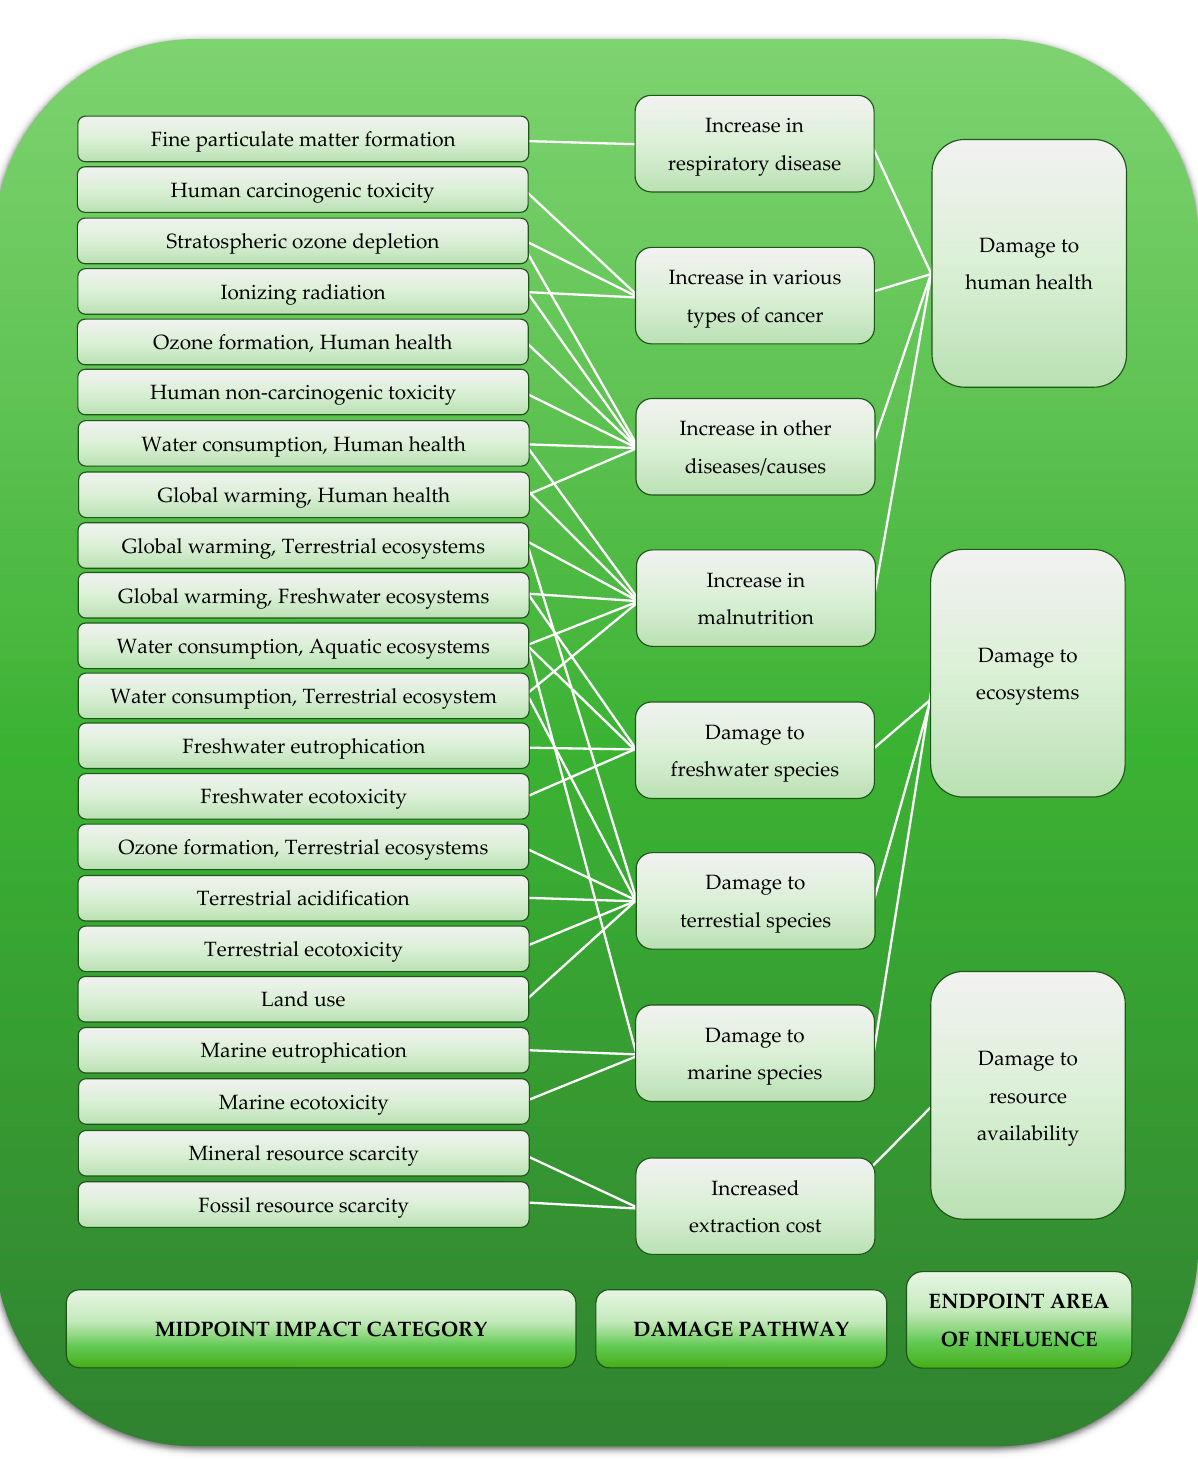
Figure 5. Overview of the impact categories that are covered in the ReCiPe 2016 method and their relation to the areas of influence.